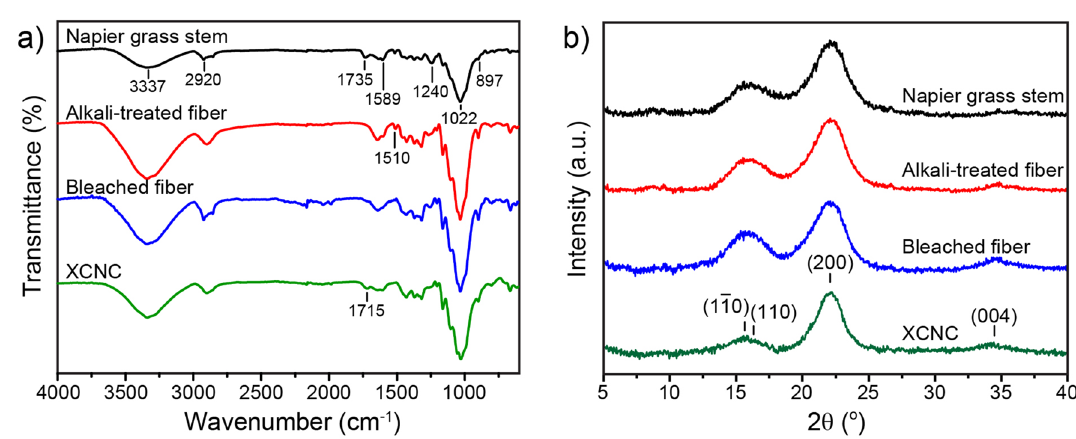
Figure 3. FTIR results ( a ) and XRD patterns ( b ) of the samples during the XCNC